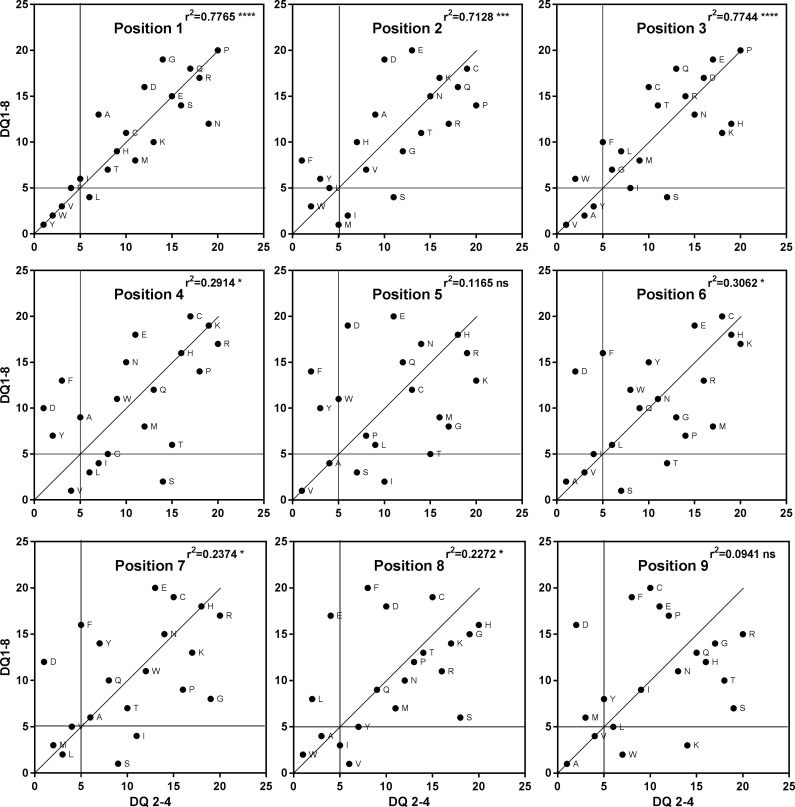
Comparison of amino acid ranking from MPSLs derived for DQ1-10 and DQ2-4 in dolphin.Predicted binding affinities for the (20 x 9 = 180) mixtures obtained from the model positional scanning libraries derived from proteins encoded by dolphin alleles DQA1*01DQB 1*10 (DQ1-10) and DQA1*02 DQB1*04 (DQ2-4) were ranked from 1–20, where 1 represents the lowest value and therefore highest binding affinity. Correlations were performed on scatterplots, coefficients of determination (r2) derived from Pearson coefficients (r) are recorded in upper right corner. Vertical and horizontal lines demark amino acids ranked below 5.